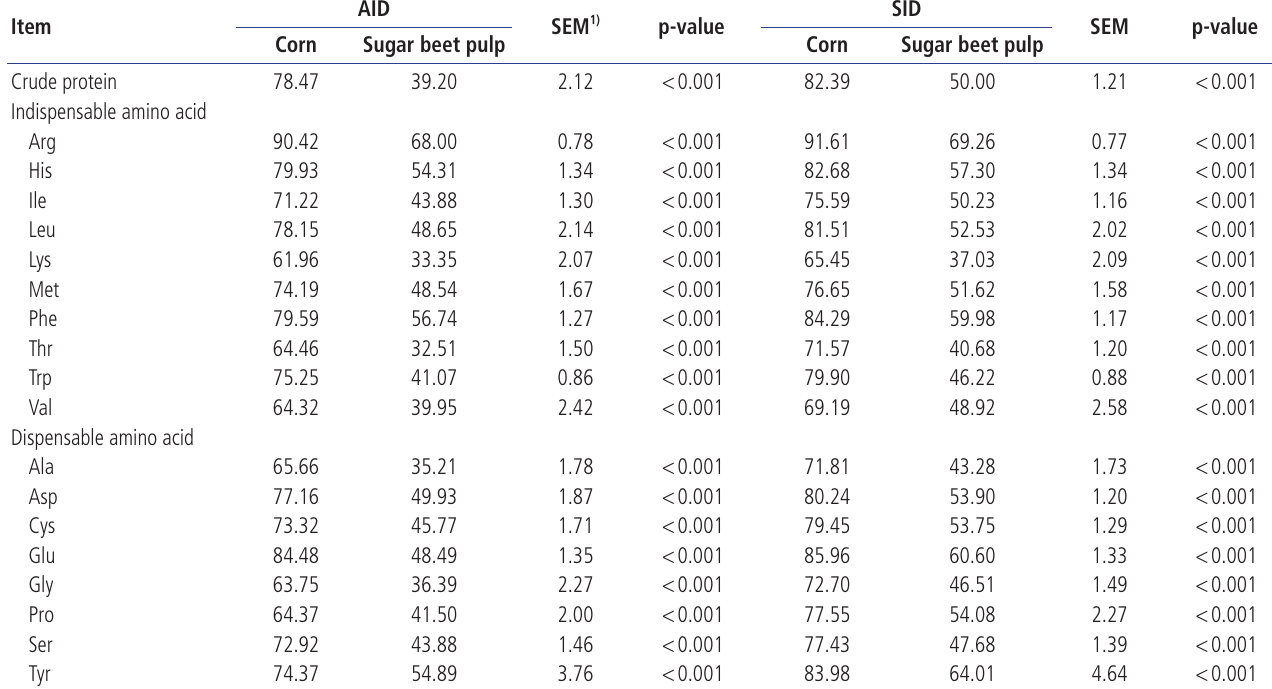
Table 5. The effect of adaptation time and inclusion level of sugar beet pulp on the digestible energy (DE, kcal/kg, as-fed basis) value, ATTD (%) of GE and CP of sugar beet pulp fed to pigs in Exp. 1 1) Items